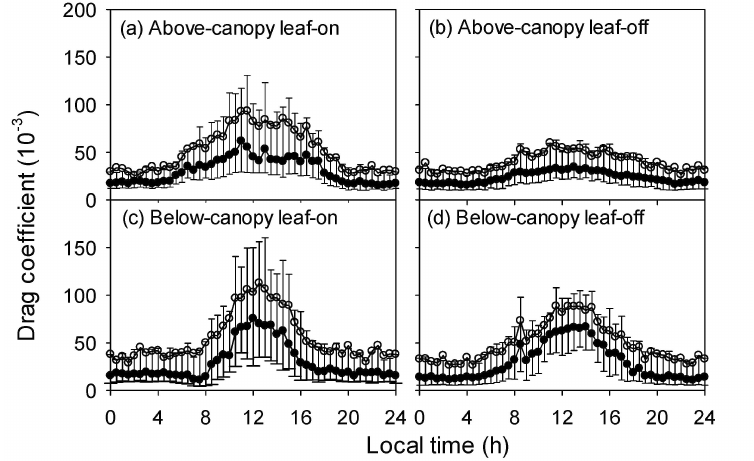
Figure 8. Diurnal courses of drag coefficients above (36 m) and bellow (2 m) the canopy during the leaf-on and leaf-off seasons of 2012. ( a ) above-canopy for leaf-on season, ( b ) above-canopy for leaf-off season, ( c ) below-canopy for leaf-on season, and ( d ) below-canopy for leaf-off season. Open circles are mean values, filled circles are the median and error bars indicate the range between the 25 and 75 percentile,